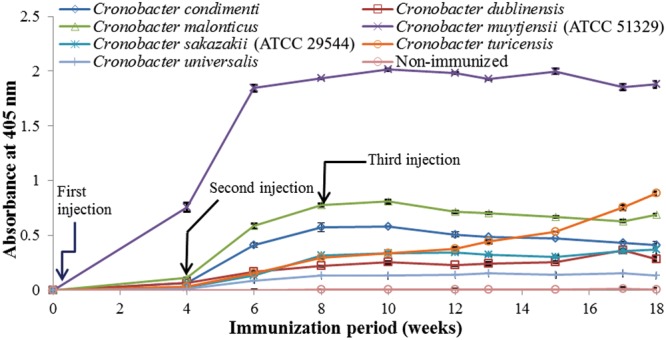
Titers of rabbit anti-serum developed from formalin killed cells mixture against seven Cronobacter species. All experiments were conducted three times, and data represent mean ± standard deviation.